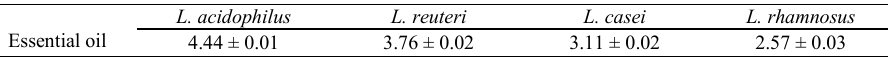
Table 4. Antibacterial effect of nano emulsion of clove essential oil on probiotic bacteria